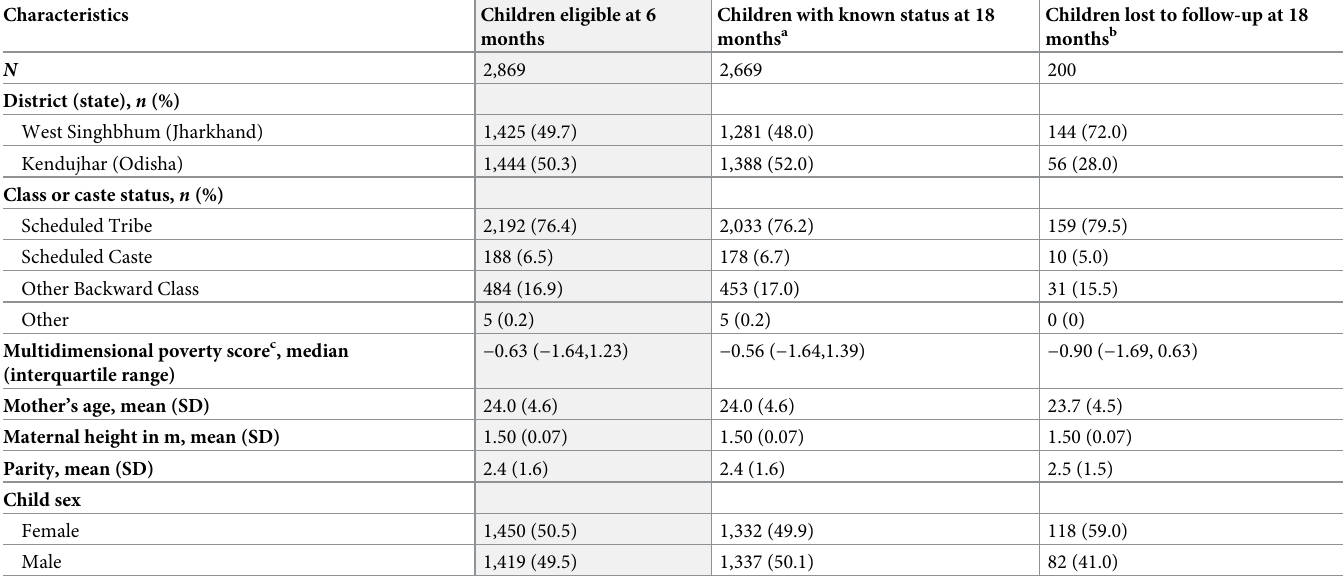
Table 1. Characteristics of